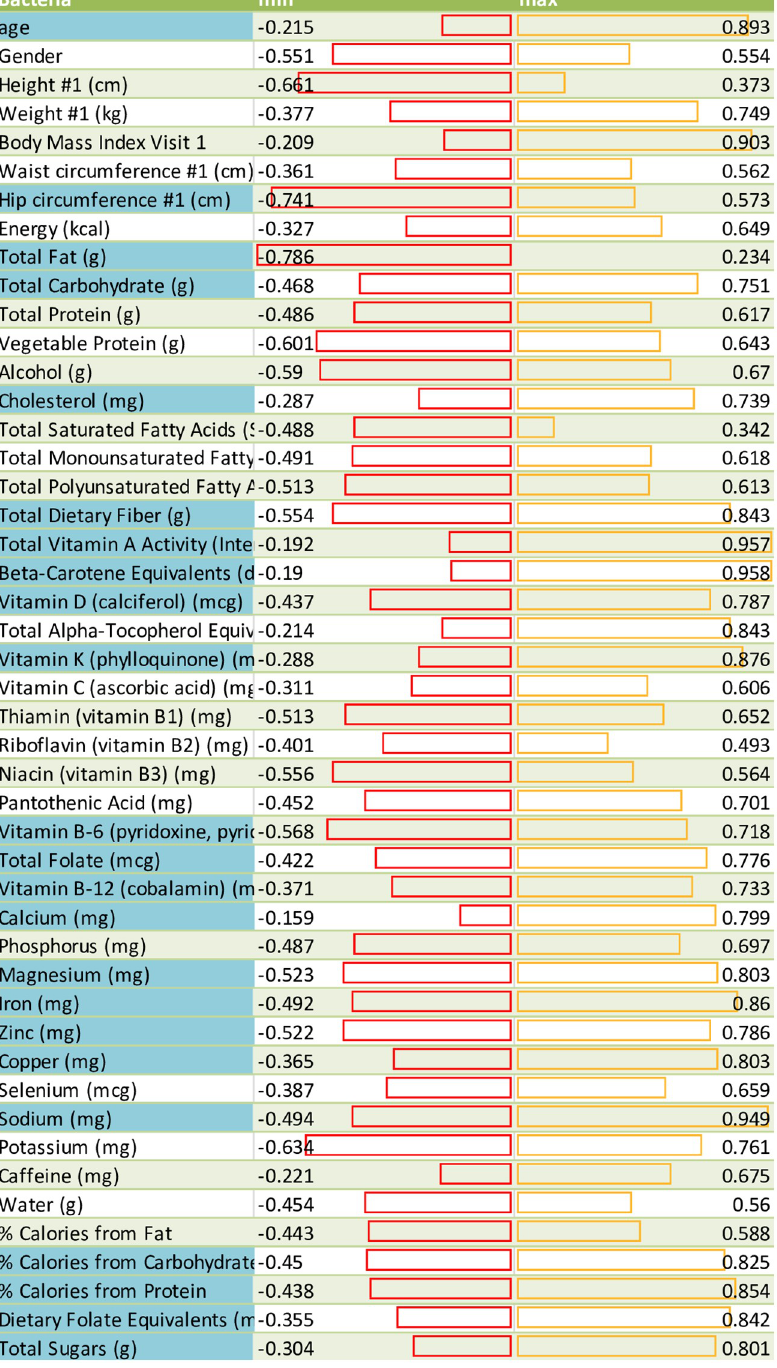
Fig 4. The range of correlation for all features that have been measured for each of the GW samples. Each line is a graph of the min and max values using a Cosine Similarity coefficient correlation. A positive value means strong correlation, and a negative value means strong anticorrelation, whereas zero means absolutely no correlation. Given the size of sample pool of 16, 0.7 is taken as the marginal threshold for evidence of some degree of correlation. Each feature that had a correlation with any organism is highlighted in blue. For example, some characteristics such as fat intake have anticorrelation with members of Campulobacter jejuni and Eubacterium family.